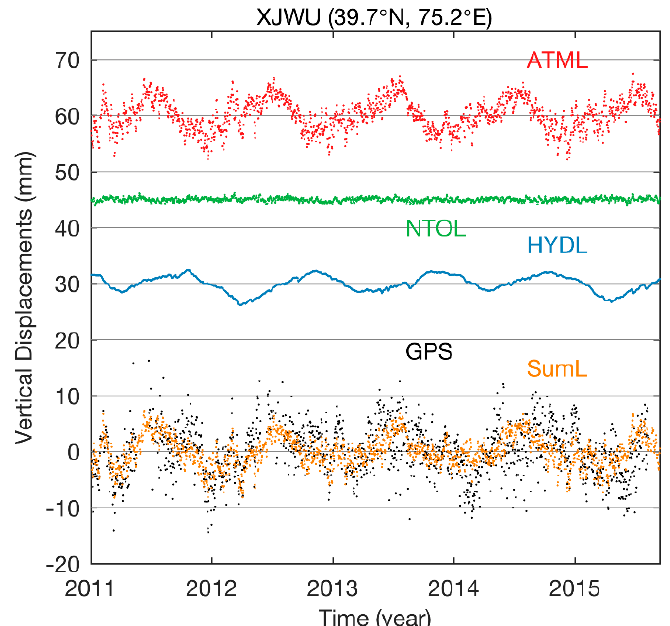
Figure A6. Vertical displacement time series due to atmospheric loading (ATML, red), non-tidal oceanic loading (NTOL, green), hydrological loading (HYDL, blue), and their summation (SumL, orange) predicted with GFZ loading products and GPS height time series (black) for station XJWU. The ATML, NTOL, and HYDL time series are shifted upward by 60, 45, and 30 mm, respectively. Table A1. The earthquakes which caused co-seismic and/or post-seismic deformation of the CMONOC stations (http://www.globalcmt.org/CMTsearch.html [51,52]).